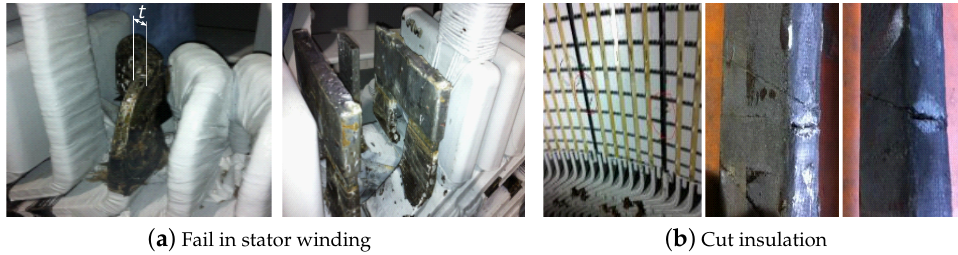
Figure 6. Examples of fails that have occurred in Unit 5 in the last years. For reference, the thickness t of a stator bar is about 17